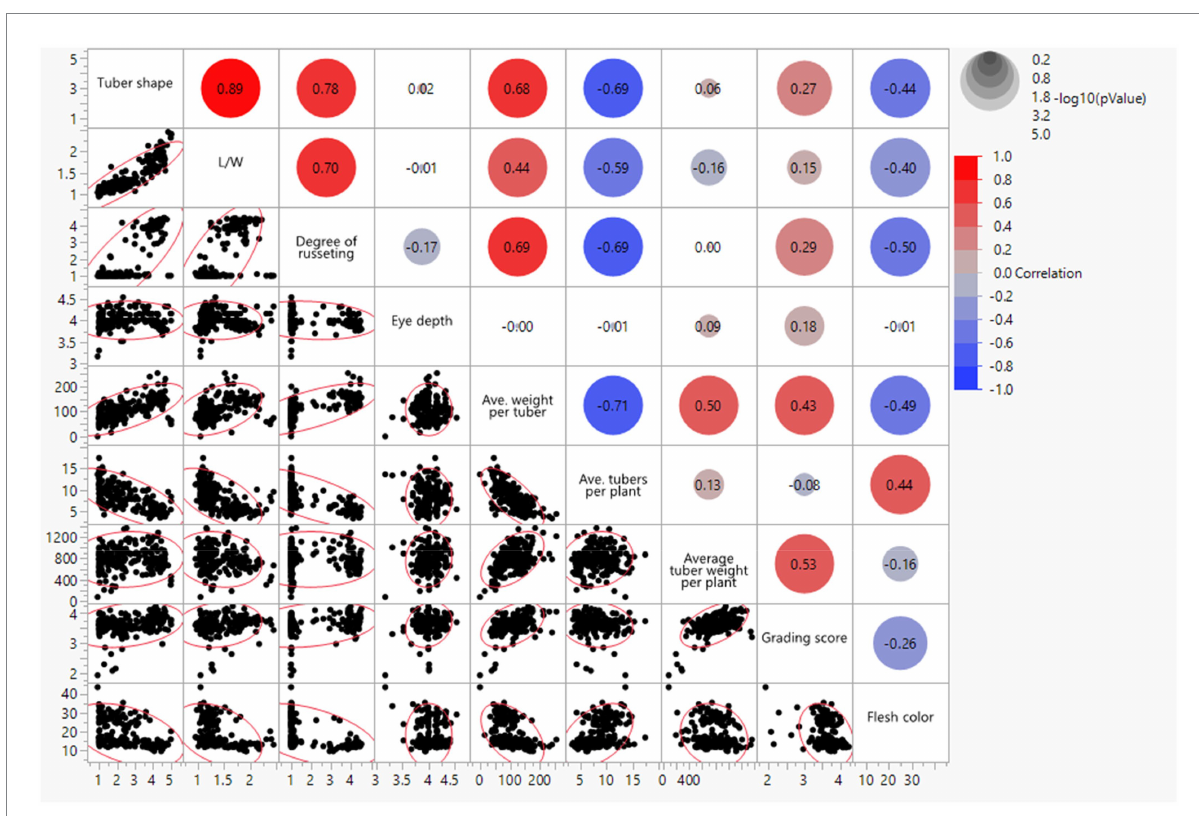
FIGURE 2 Bivariate scatter plots with a fitted line (bottom of the diagonal) and the value of the correlation (top of the diagonal) for tuber traits of 214 potato clones evaluated in three environments in Texas: Dalhart 2019, 2020, and Springlake